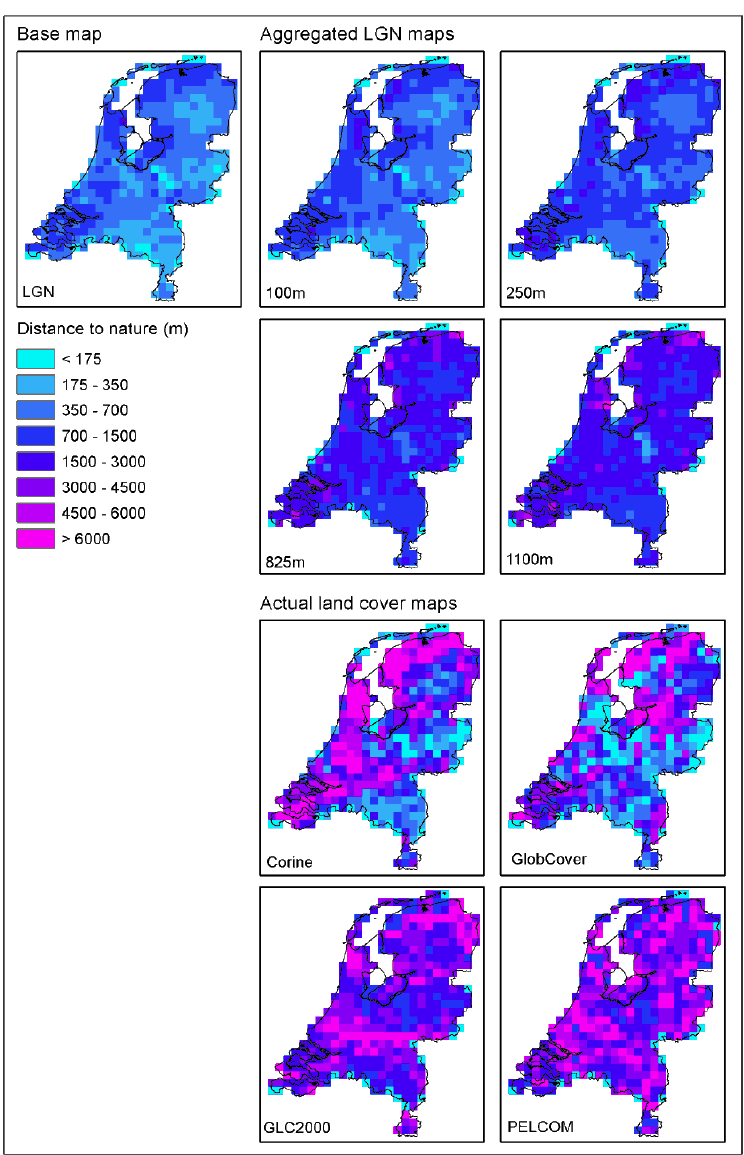
Figure 3. Distance to nature in agricultural areas. ( Top left ) Base map; ( Top ) Maps based on aggregated LGN; ( Bottom ) Maps based on real land